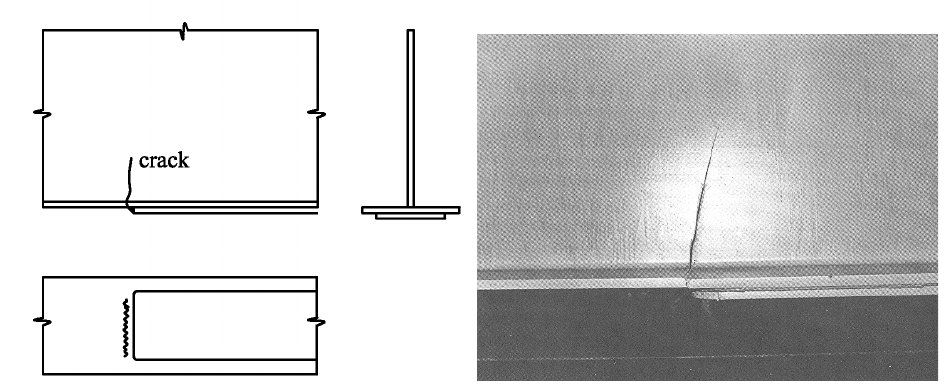
Figure 24. Fatigue cracking of cover-plate ends